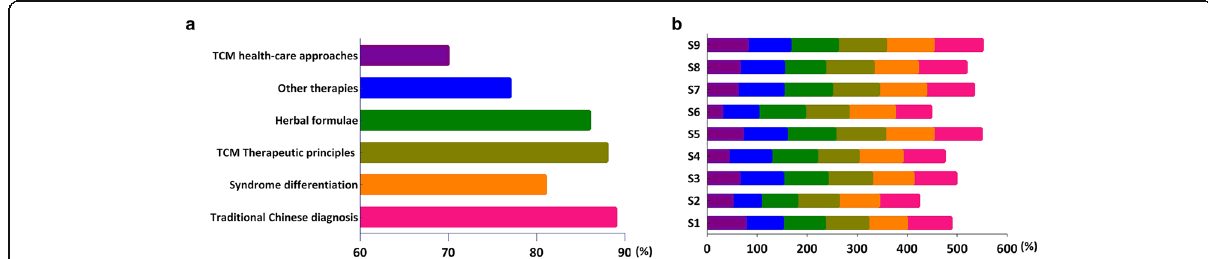
Fig. 3 Attitudes towards various Chinese medicine items of clinical practice guidelines (%). a Attitudes towards six Chinese medicine items of CPGs. Six items include traditional Chinese diagnosis ( pink ), syndrome differentiation ( orange ), CM therapeutic principles ( olive ), herbal formulae ( green ), other therapies ( blue ) and CM health-care approaches ( purple ). Perceived approval rating for each of the key CM diagnosis and treatment recommendations were determined by calculating the percentage of respondents that either agreed or strongly agreed (score 3 and 4). The following are some of the characteristics of CM: (cid:129) syndrome differentiation ( 辨 證 ) the process of overall analysis of clinical data to determine the location, cause and nature of a patient ’ s disease and achieving a diagnosis of a pattern/syndrome, also called pattern differentiation. (cid:129) therapeutic principle & method of treatment ( 治 則 治法 ) a general rule that should be followed in treating disease and any specific intervention derived from a principle of treatment. (cid:129) formula ( 方 劑 ) prescription, recipe. (cid:129) CM health-care approaches ( 養 生 ) traditional health-care to promote health,